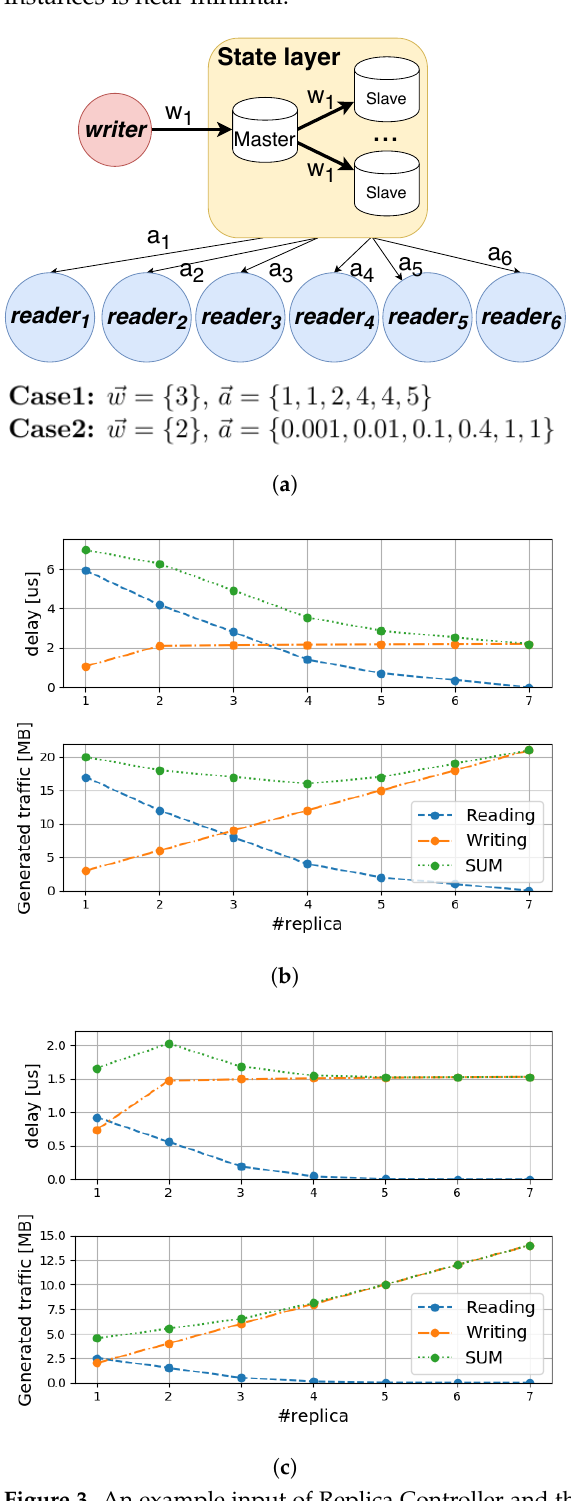
Figure 3. An example input of Replica Controller and the corresponding delay and traffic values depending on the number of state instances. ( a ) A stored state whose master/slave instances are written by one and read by six NF instances with different writing and reading rates. ( b ) Total network delay and generated traffic depending on number of state instances in the read-heavy first case. ( c ) Total network delay and generated traffic depending on number of state instances in the write-heavy second